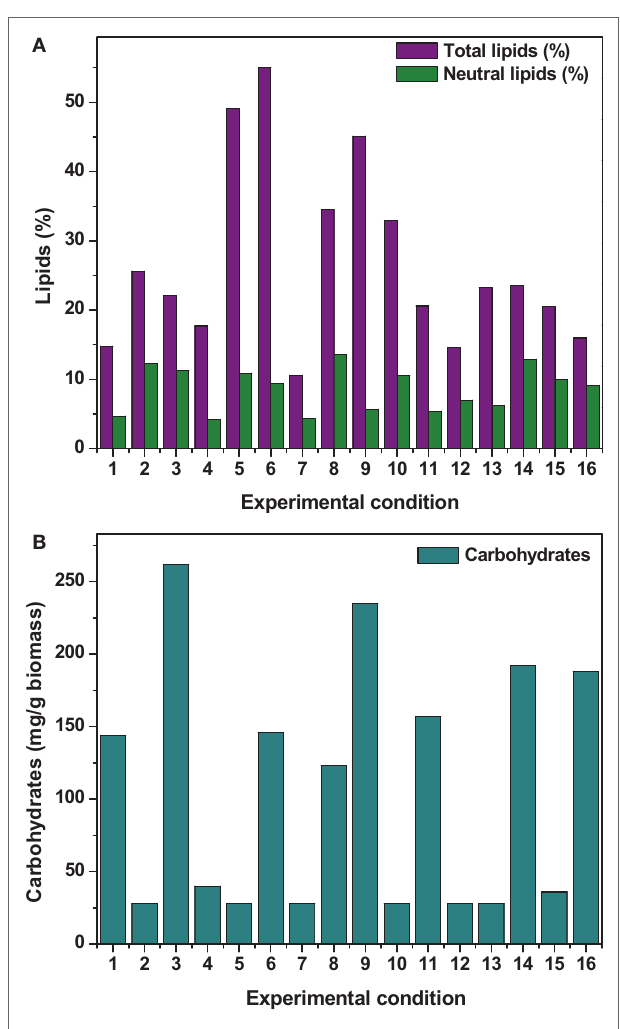
FigUre 1 | (a) Total lipid and neutral lipid (B) carbohydrates concentration obtained from all the experimental